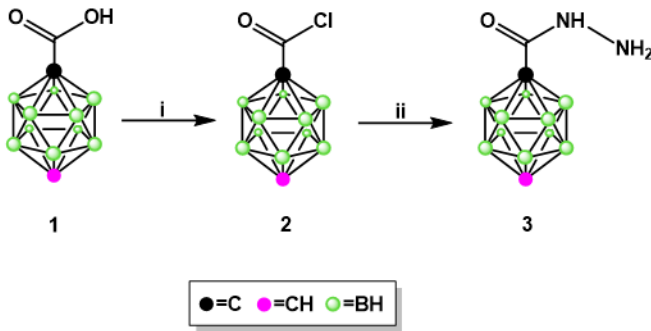
Figure 2. Synthesis of compound 3—analog of INH: ( i ) PCl5, reflux 4 h and ( ii ) NH 2 -NH 2 , reflux 5 h.